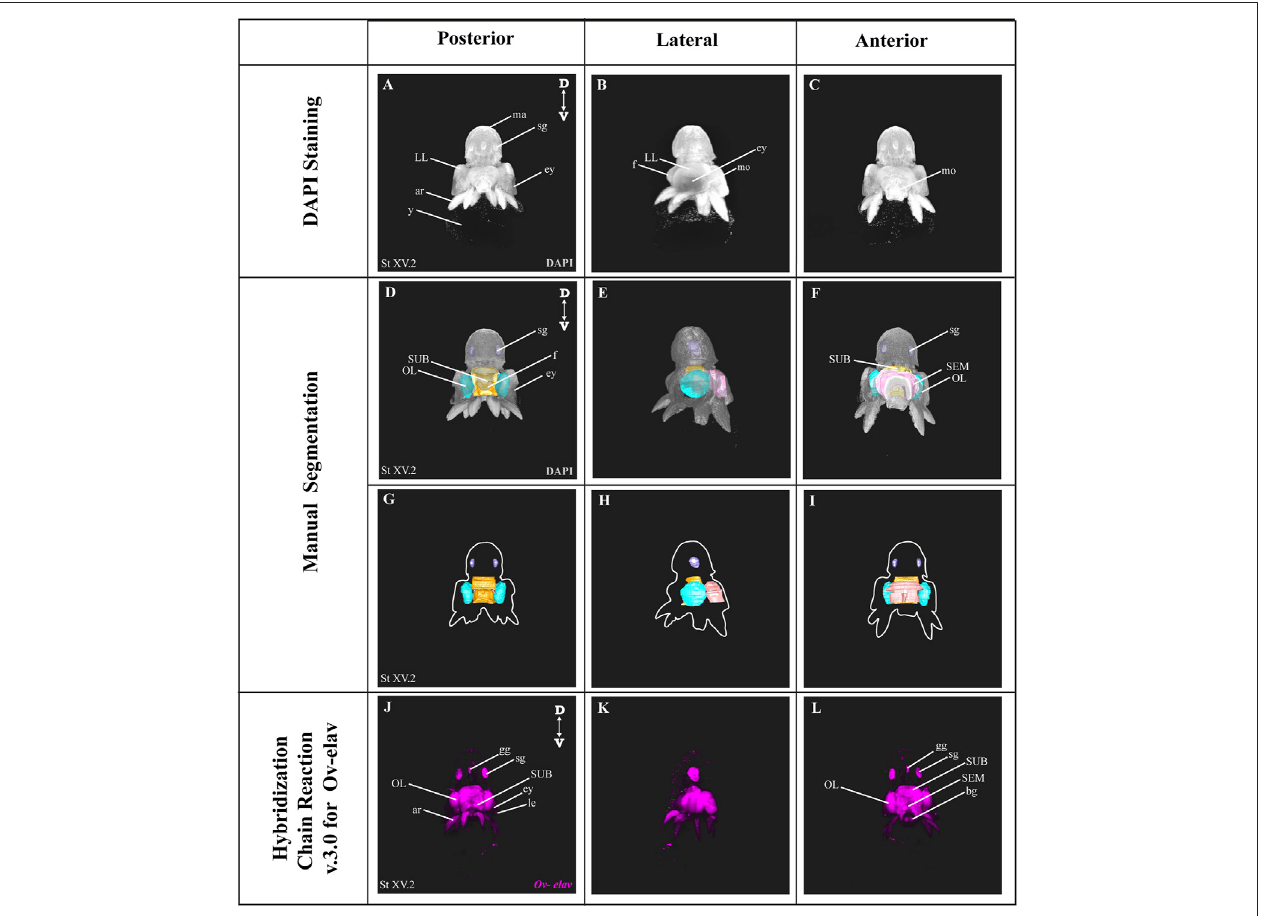
FIGURE 2 | Manual Segmentation vs. in situ hybridization chain reaction. (A – C) Maximum intensity projection of DAPI-stained developmental stage XV octopus embryo in 3D view. (D – F) 3D volumetric octopus embryo with manually reconstructed central brain as well as stellate ganglia. Color legend: light blue, optic lobes; pink, supraesophagealmass; orange, subesophageal mass; and dark blue, stellate ganglia . (G – I) Manually reconstructed central brain aswell as stellate ganglia. (J – L) in situ hybridization chain reaction (HCR) for Ov-elav on a developmental stage XV embryo. A stage XV octopus embryo is approximately 1,25 mm × 0,88 mm, from the topofthemantletilltheendofthearms. Abbreviations:ar,arm;bg,buccalganglia;D,dorsal;ey,eye;fu,funnel;gg,gastricganglion;le,lens;LL,laterallip;ma,mantle;n, neuropil; OL, optic lobe; SEM, supraesophageal mass; sg, stellate ganglion; SUB, subesophageal mass; V, ventral; y, yolk.